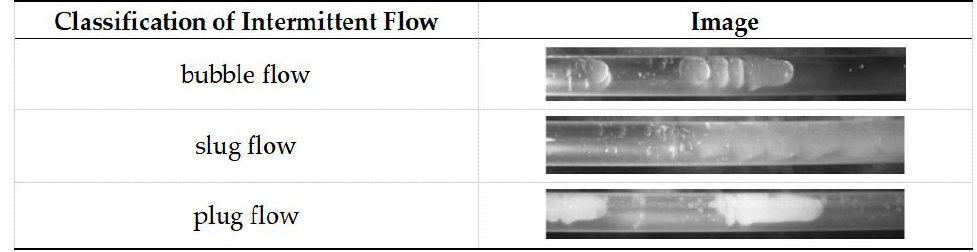
Figure 4. Classification of intermittent flow [3].